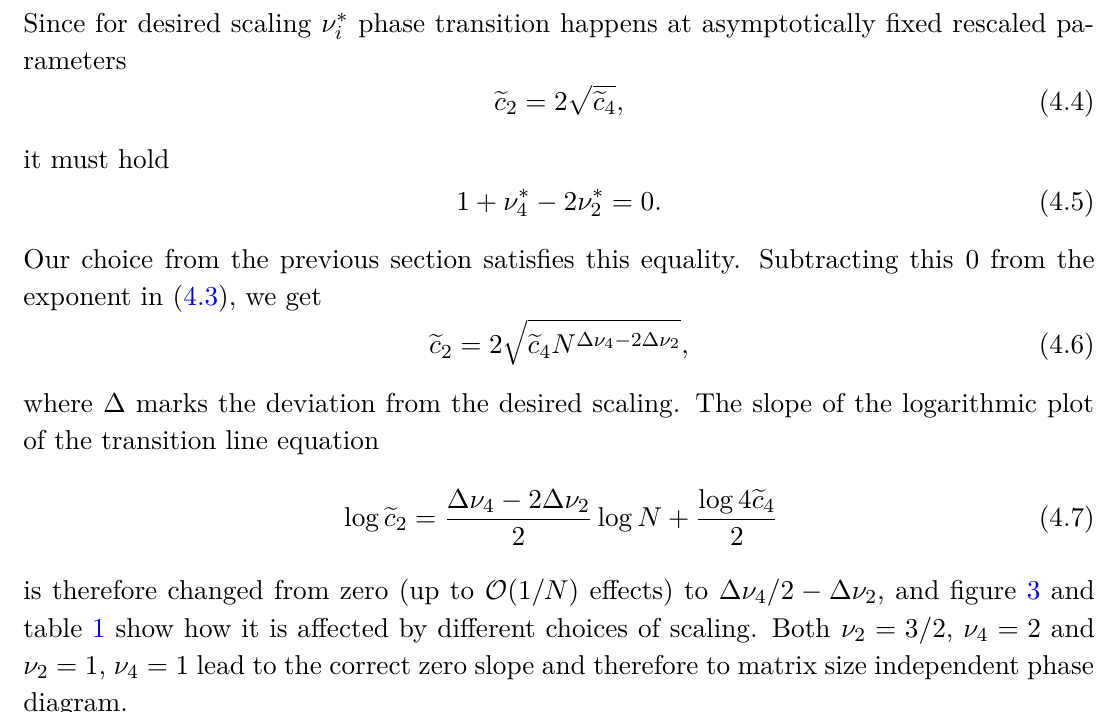
c 4 = 1 in the infinite matrix limit. e √ c 2 = 2 c 4 = 2 e e